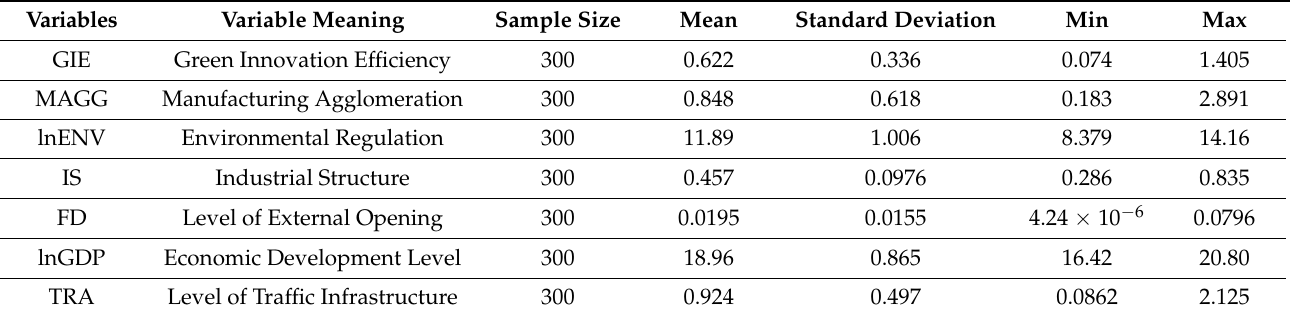
Table 3. Descriptive statistics values of